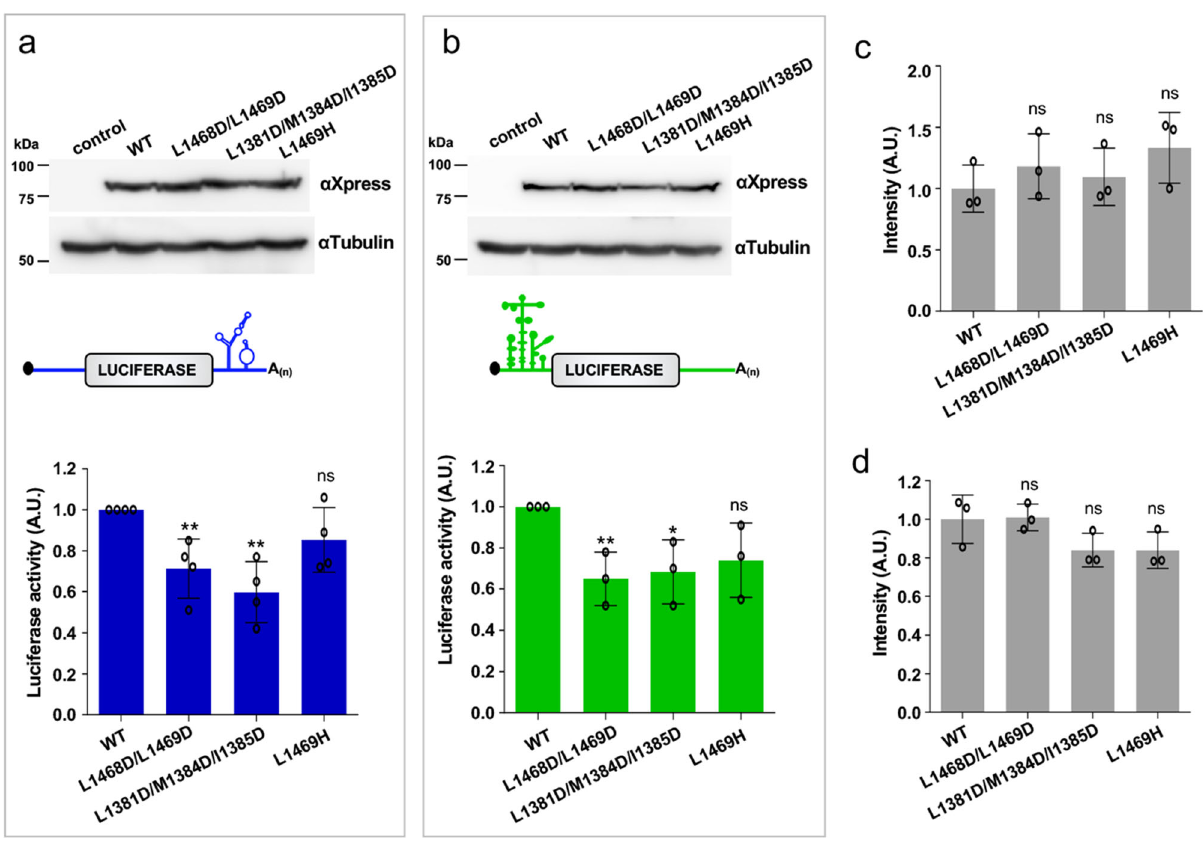
Fig. 5 | Pentamer-destabilizing mutations impair G5C selective translation. ProteinexpressioninHEK293cellswasmonitoredbyWBusinganti-XpressforG5C proteins, tubulin was used as loading control. Diagrams of the luciferase reporter mRNAsusedintheassay, a luc-SL1and b IRES-luc.Luciferaseactivitywasmeasured incelllysatesexpressingthereportermRNA, a luc-SL1or b IRES-luc,co-transfected with Xpress-G5C-WTorthe indicated mutants. Luciferase values are normalized to cells expressing Xpress-G5C-WT.Valuesrepresent the mean±SDobtained in three